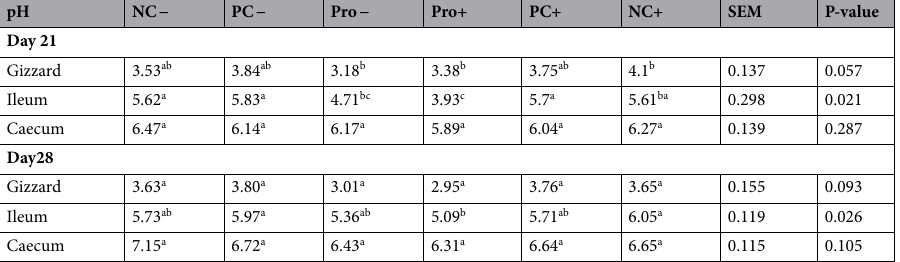
Table 5. Effects of supplementation with probiotics and challenged with Pasteurella multocida on pH of GIT of broilers. Values are means of two replicates and standard errors of means. Within each variable, values with the same superscript letter are not significantly different according to Duncan’s multiple range test (P > 0.05). NC−: unchallenged negative control; PC−: unchallenged positive control; Pro−: unchallenged probiotics control; Pro+: challenged probiotic control; PC: challenged positive control; NC+: challenged negative control.